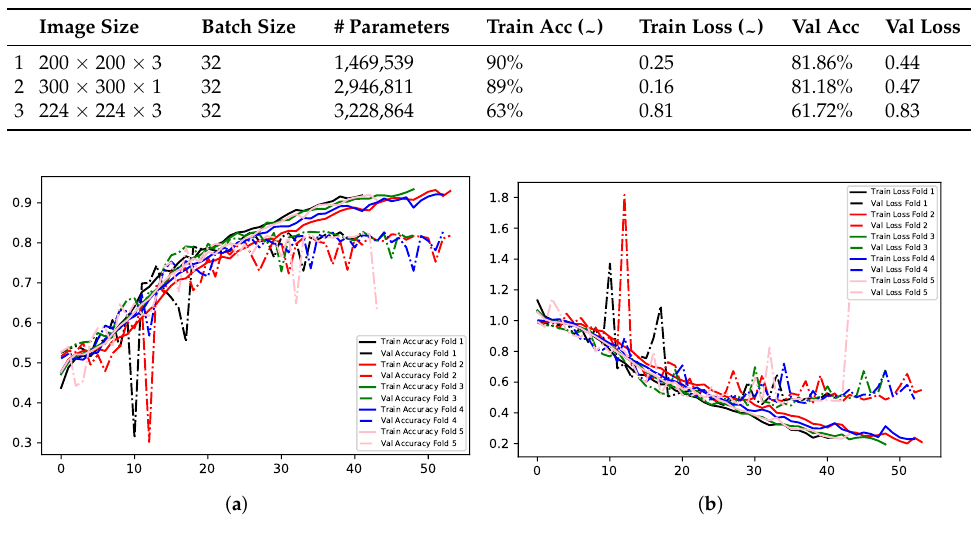
Table 5. Model B training and validation results.